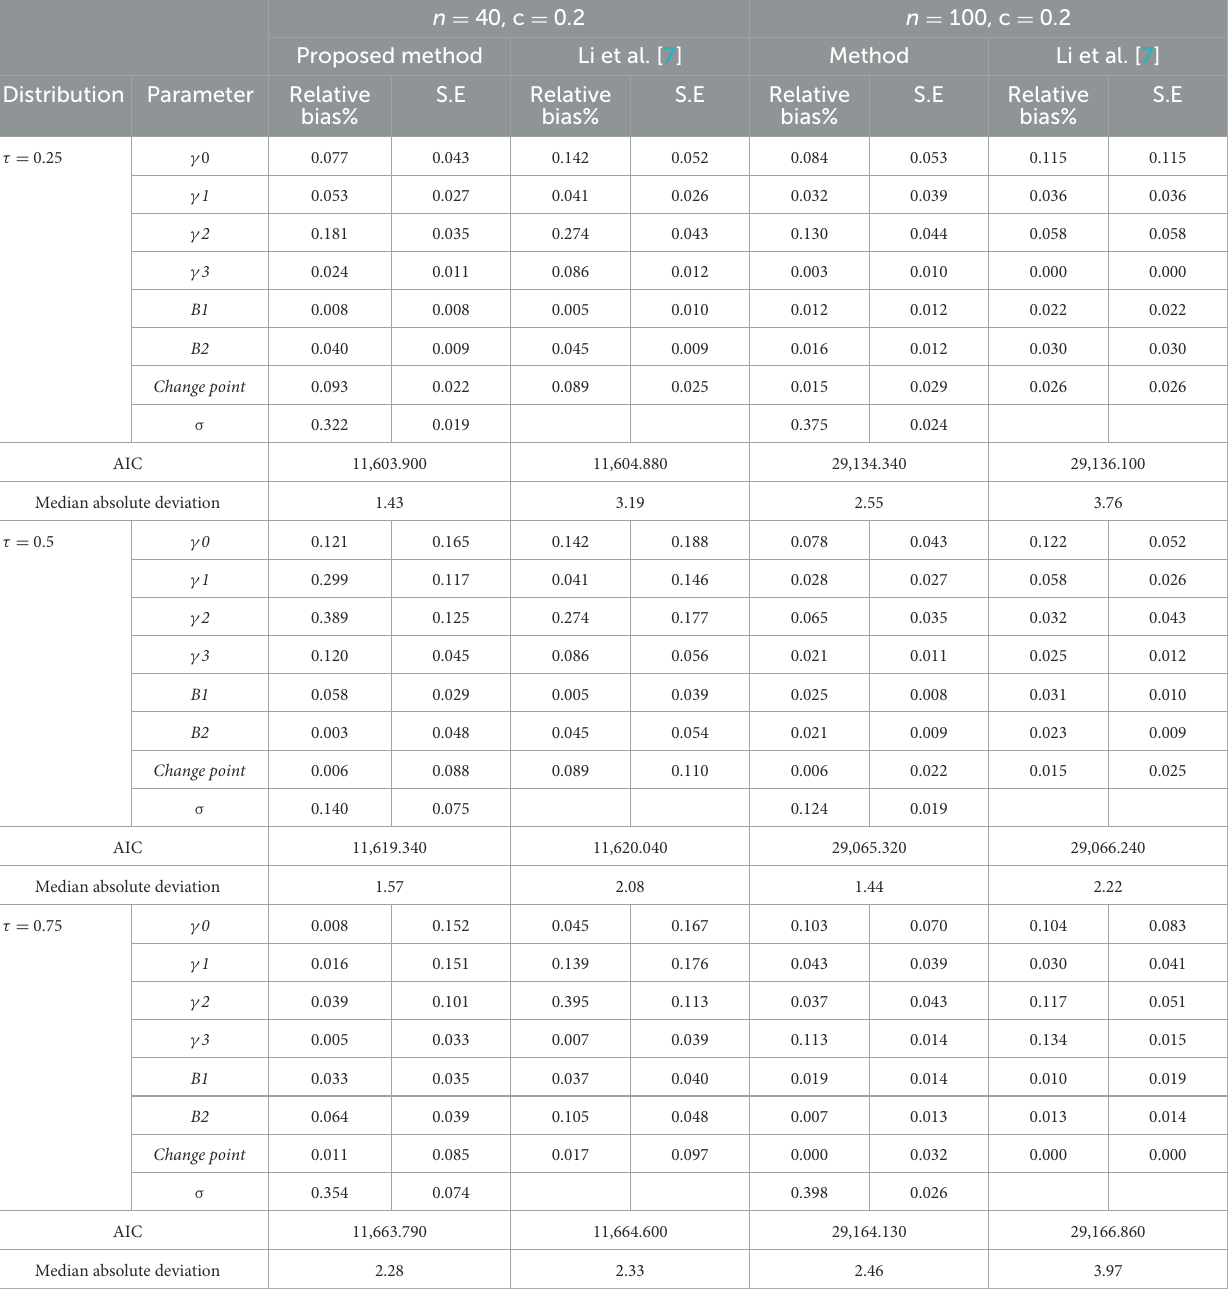
TABLE 1 Simulation results, the standard errors, and the relative bias for different models at n = 40, and 100, ε τ , ij ∼ ALD . n = 40, c = 0.2 n = 100, c =